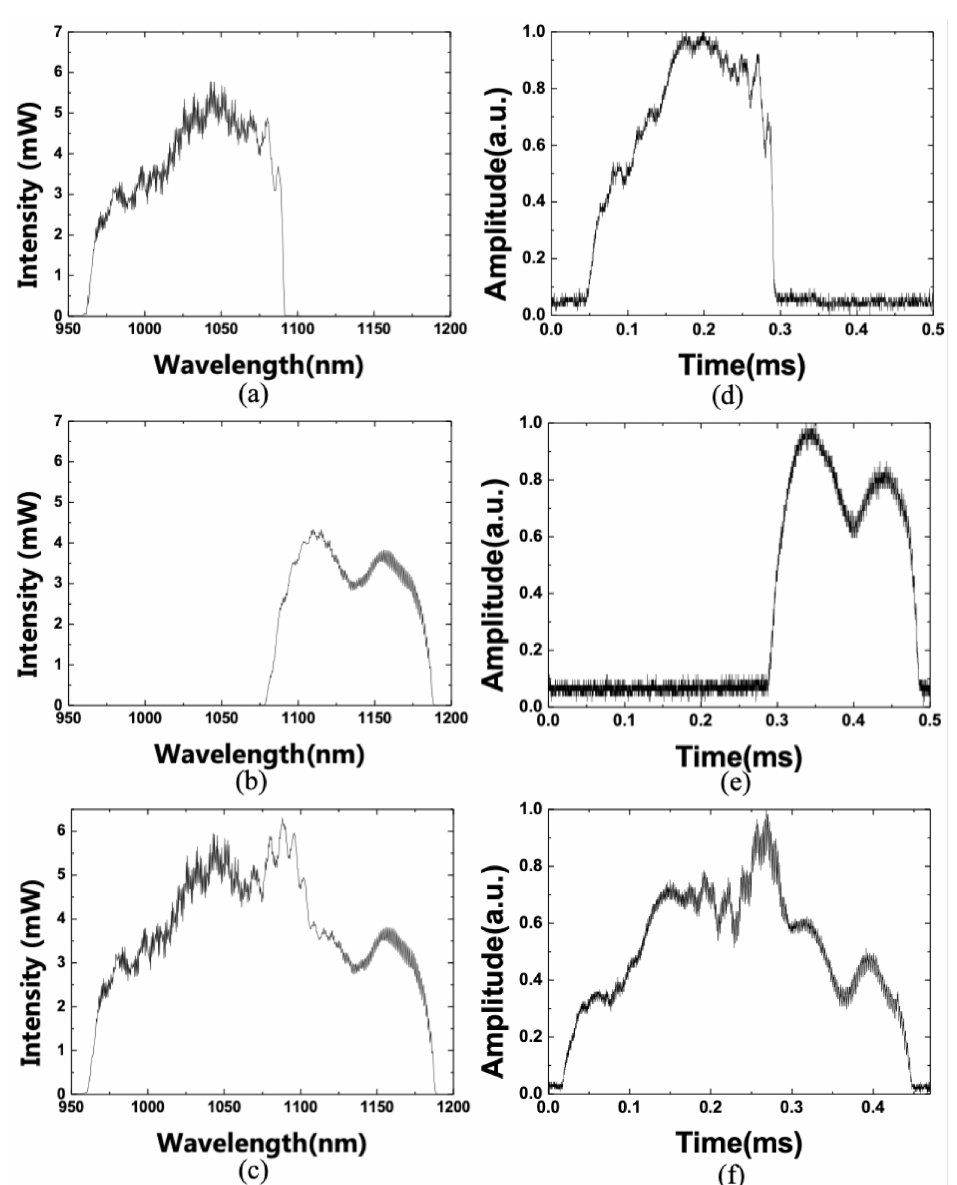
Figure 4. Optical spectrum of WSL with a linear scale ( a ) when only SOA 1 was connected, ( b ) when only SOA 2 was connected, and ( c ) when SOA1 and SOA2 were combined in a Mach-Zehnder interferometer configuration. ( d – f ) Output pulses in the temporal domain corresponding to ( a – c